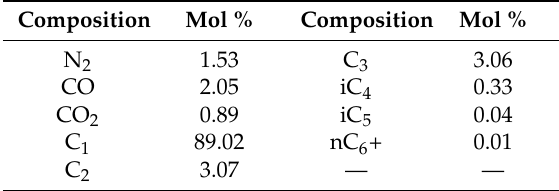
Table 1. The composition of gas samples.